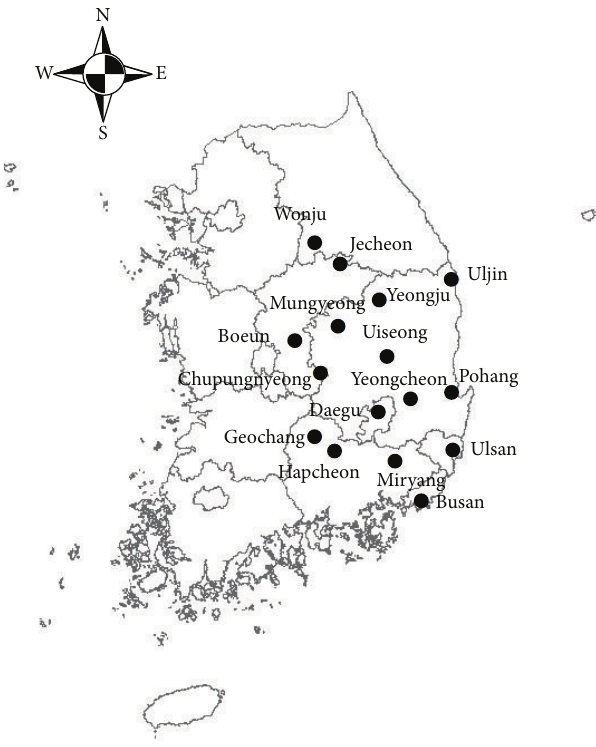
Figure 1: Weather stations of which rainfall data are used in this